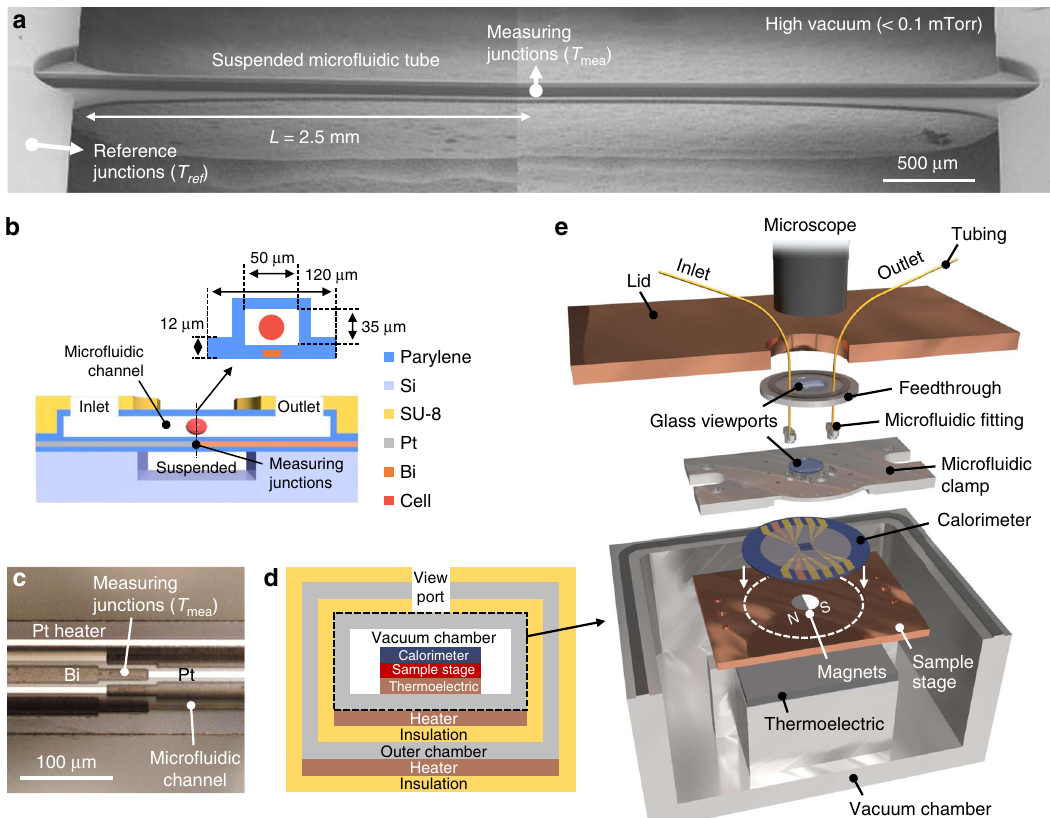
Fig. 1 Design of single-cell calorimeter and measurement platform. a SEM image of calorimeter with a 5-mm long (2 L ) one-dimensional suspended micro fl uidic channel. The calorimeter is surrounded by a vacuum environment to reduce heat loss. More than 10 samples ( n > 10) with the same geometry were reproducibly fabricated. b Cross-sectional schematic illustration of calorimeter. c Photograph of middle of suspended channel, including measuring junctions of the Bi – Pt thermopile and a Pt heater. d Schematic illustration of thermal insulation design of measurement platform with three temperature- controlled layers (outer chamber, vacuum chamber, and sample stage). e Schematic illustration of components of the vacuum chamber. Photographs of the setup are shown in Supplementary Fig.